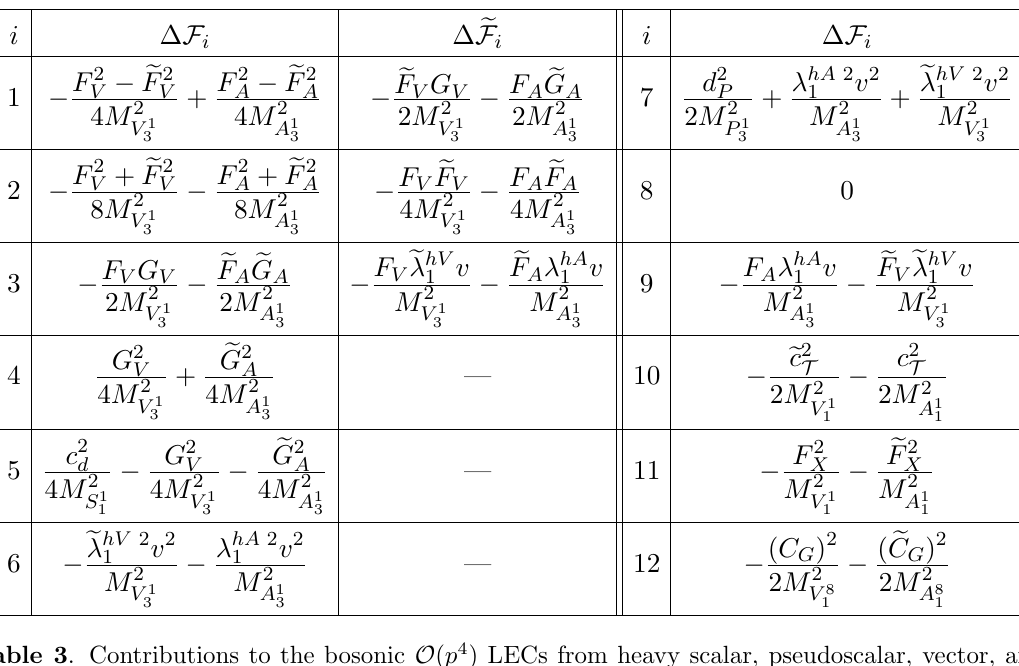
Table 3 . Contributions to the bosonic O ( p 4 ) LECs from heavy scalar, pseudoscalar, vector, and axial-vector exchanges.